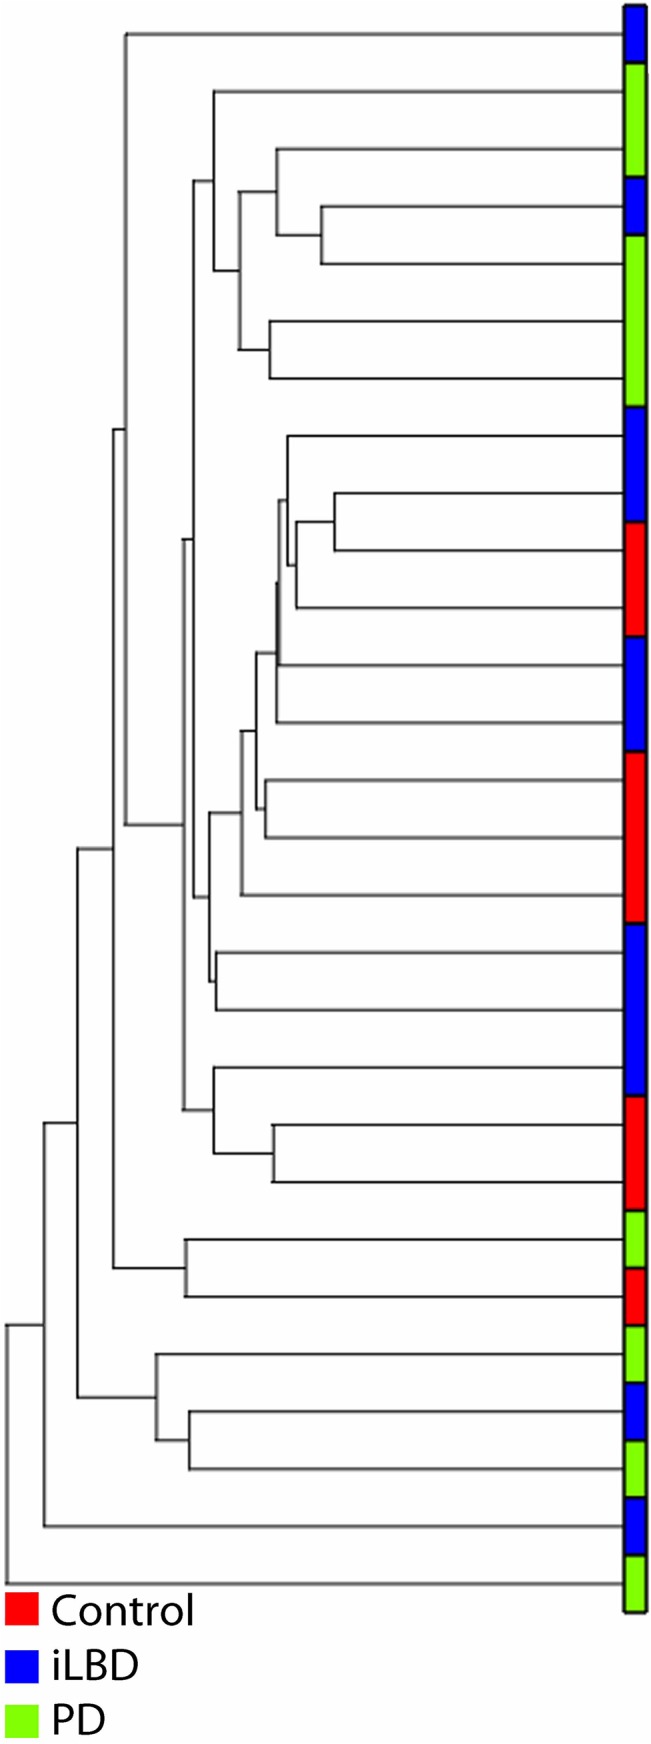
Unbiased hierarchical clustering of all gene expression profiles of iLBD, PD and control donors.Red is control, blue is iLBD and green is PD donor. The two main clusters are formed by 1) controls and iLBD and 2) PD and iLBD, indicating that the expression of iLBD is intermediate between control and PD. Seven samples clustered separately from the two main clusters. There were no technical reasons however, to exclude these donors from the analysis.